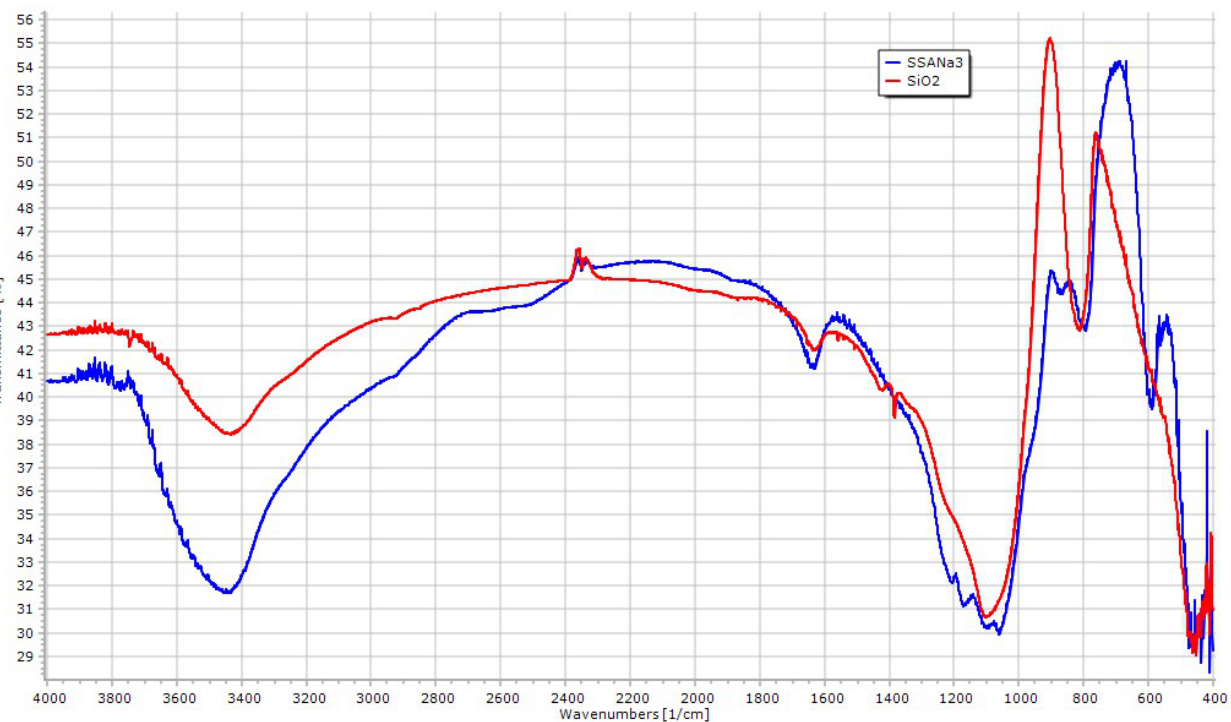
Figure 4. IR spectra of SSANa (3.0 mmol/g, blue) vs. SiO 2 (red).